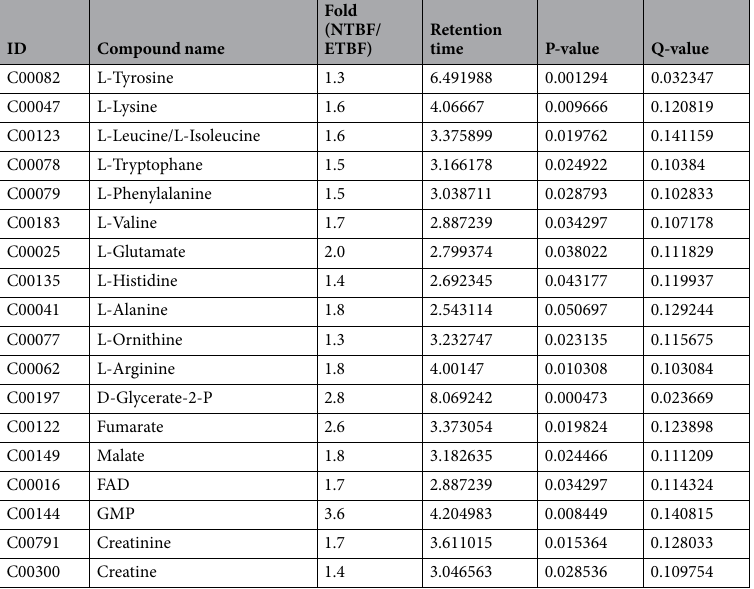
Table 2. Results of quantitative analysis of metabolic compounds of OMVs isolated from ETBF and